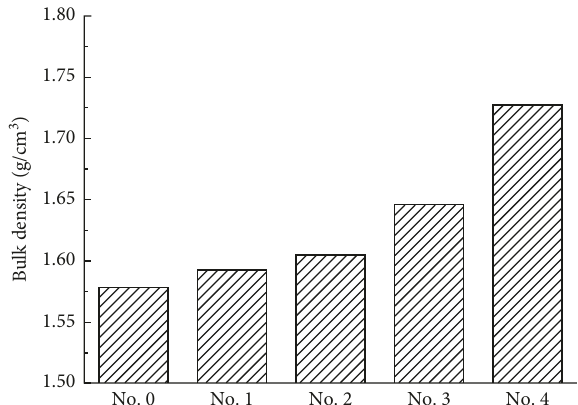
Figure 5: Measured bulk density of MICP-treated sand after curing for 28